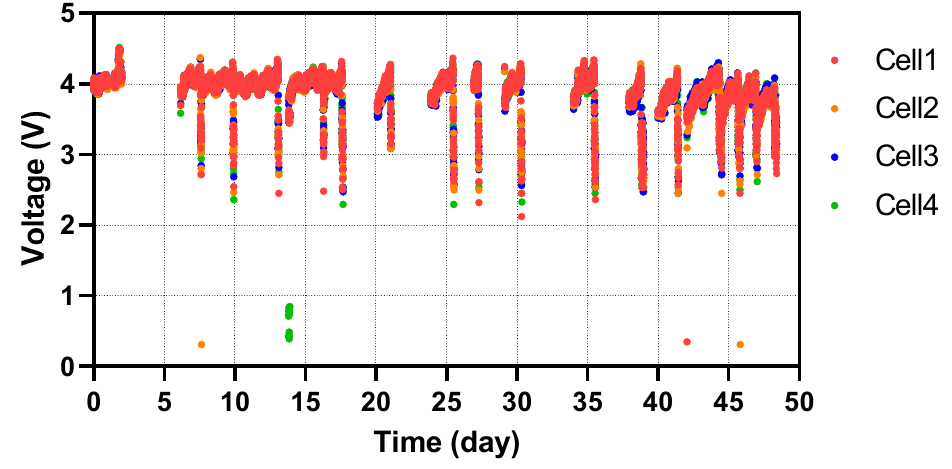
Figure 4. Pee Power system performance monitored between 19 July and 8 September 2017.